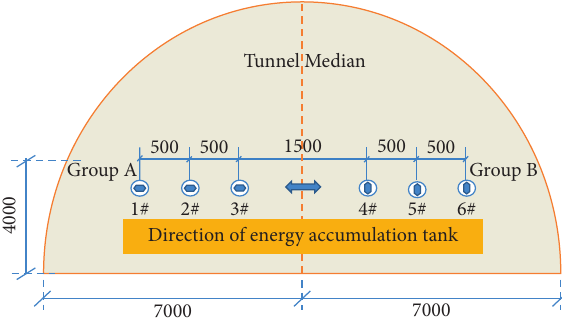
Figure 4: Arrangement of blasting hole in plugging blasting